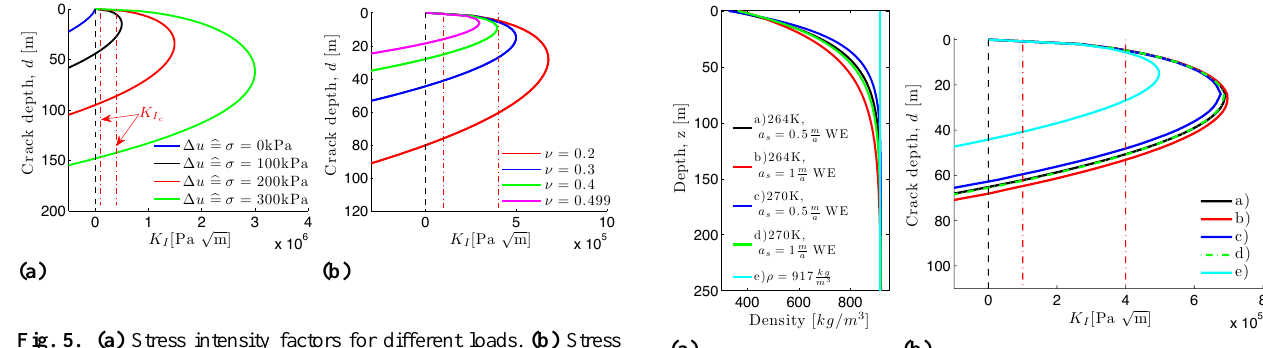
Fig. 5. (a) Stress intensity factors for different loads. (b) Stress intensity factors resulting from different constant Poisson’s ratios.